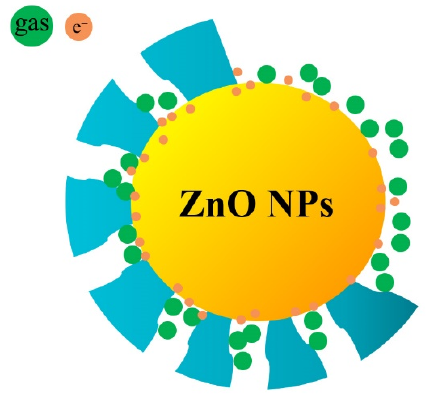
Figure 17. Schematic diagram of the ZnO@ZIF-8 composite with incomplete coating.